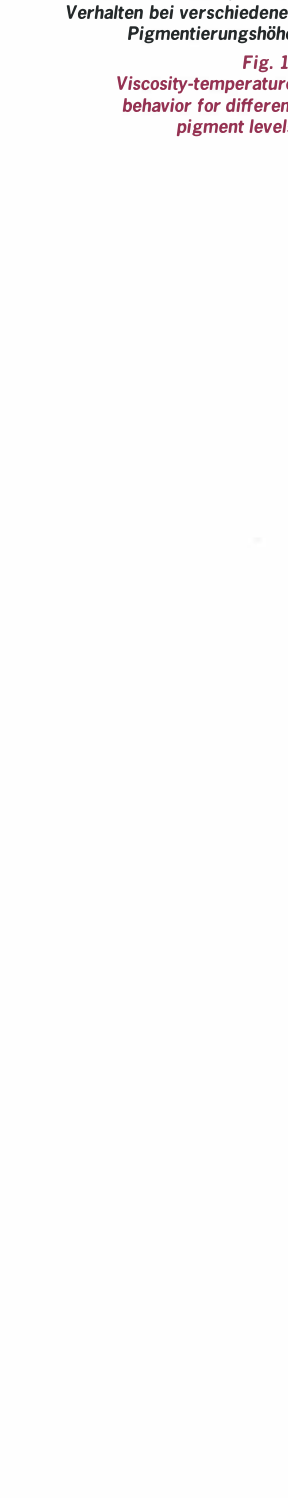
Fig. l: Viscosity-temperature behavior for different pigment